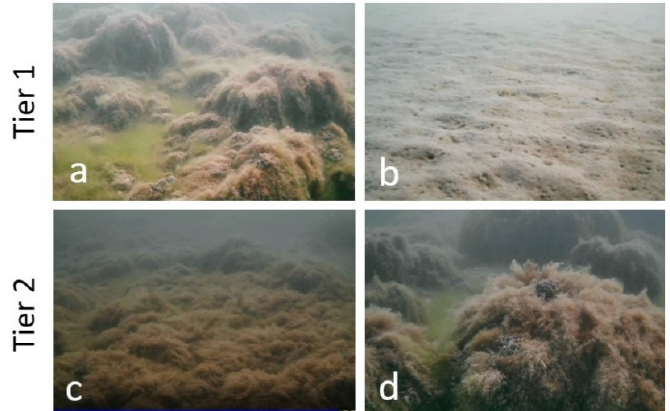
Figure 8. Underwater photo samples for Tier 1 biotic classes: ( a ) aquatic vegetation bed and ( b ) biotic null; Tier 2 aquatic vegetation bed biotic classes: ( c ) Cladophora sp. and ( d ) Cladophora sp. with co-existing attached mussels.